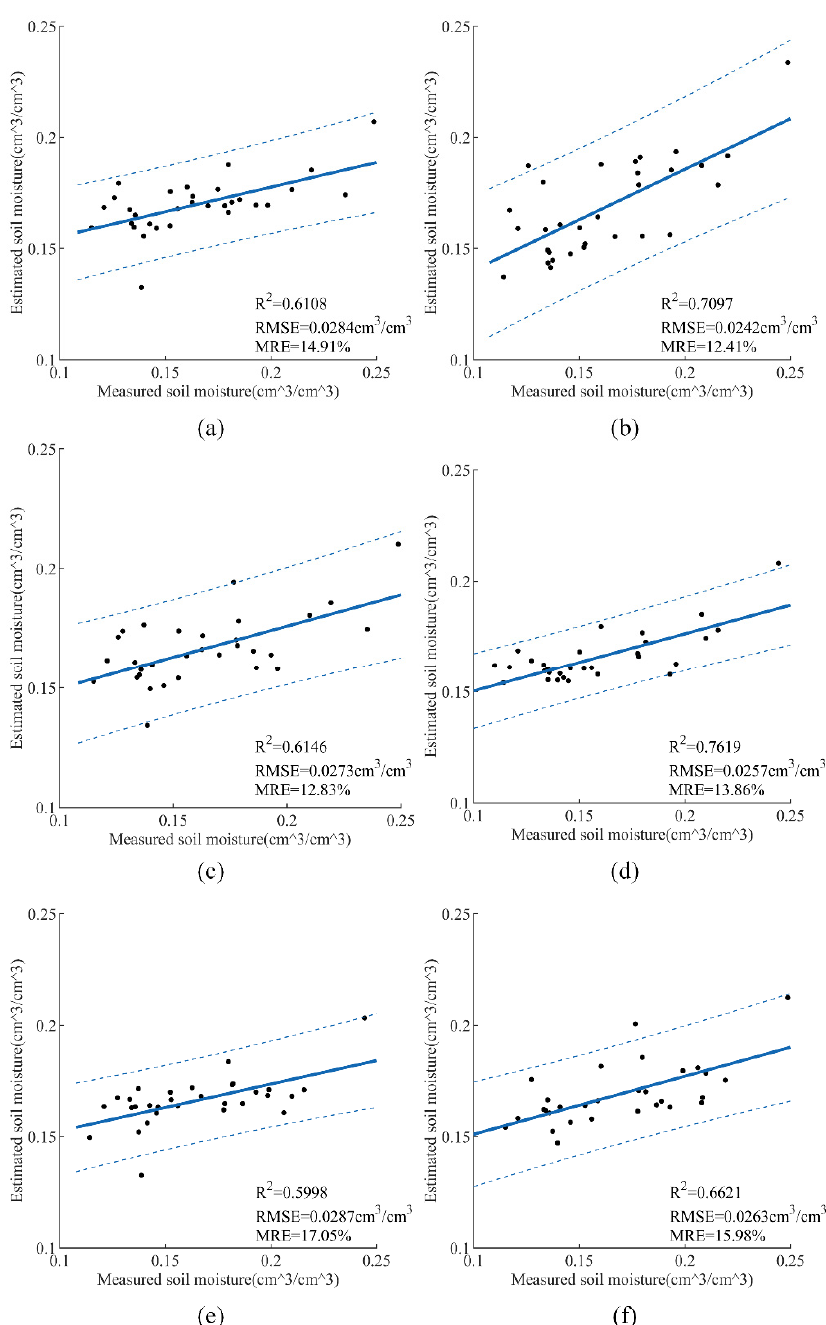
Figure 7. SMC retrieval results of the support vector regression (SVR) model with different feature combinations: ( a ) σ 0 + σ 0 + Digital Elevation Model (DEM) + local incidence angle (LIA) + VH VV